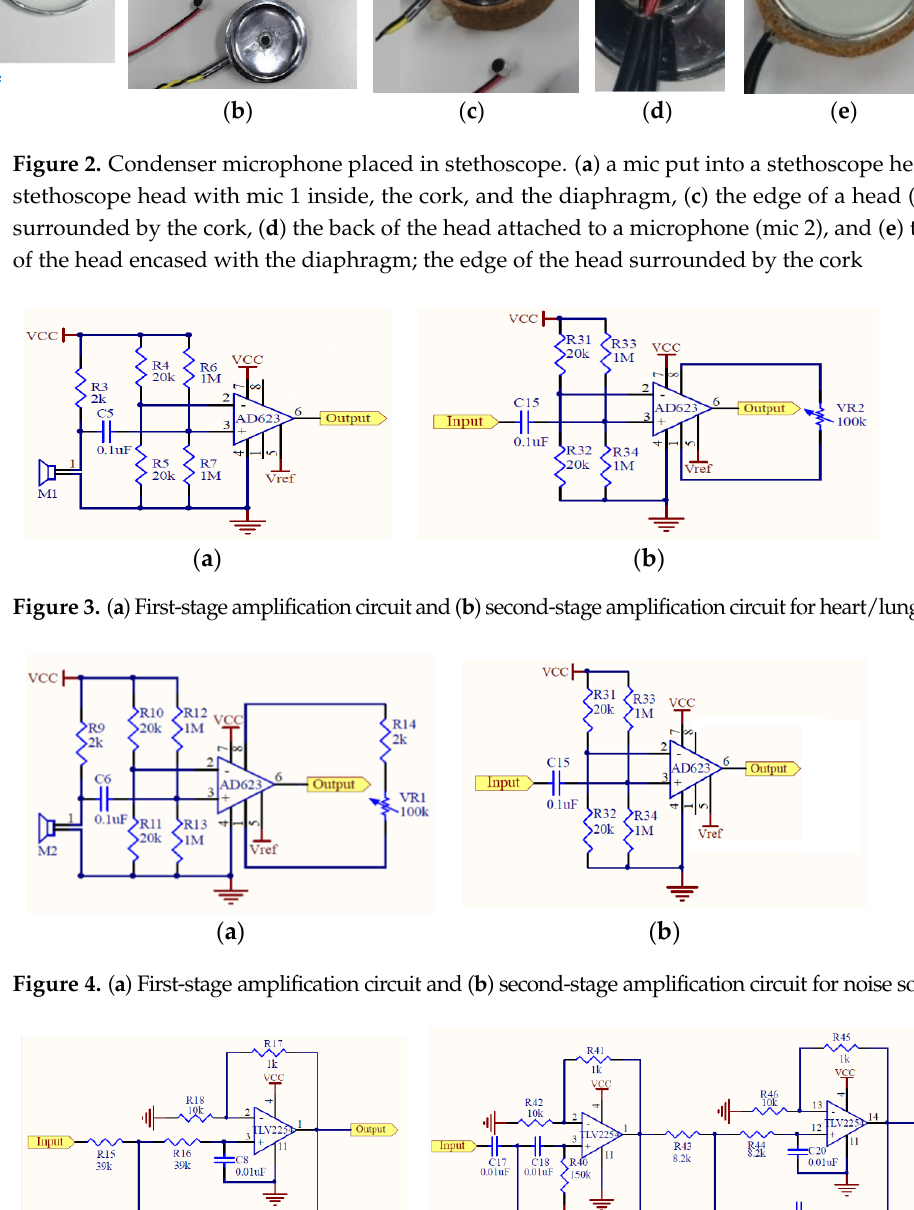
Figure 6. Circuit diagram of the presented system. A graphical user interface (GUI) for recording sounds was also developed during the course of this study. For noise reduction, we designed 5 different models of electronic stethoscope heads as shown in Table 1 [24], where a commercial electronic stethoscope was included. Two microphones were used in Models 1~2, one inside the stethoscope head for collecting heart/lung sounds and the other on the back of the stethoscope head for collecting environmental noise. The difference between these two models is that one